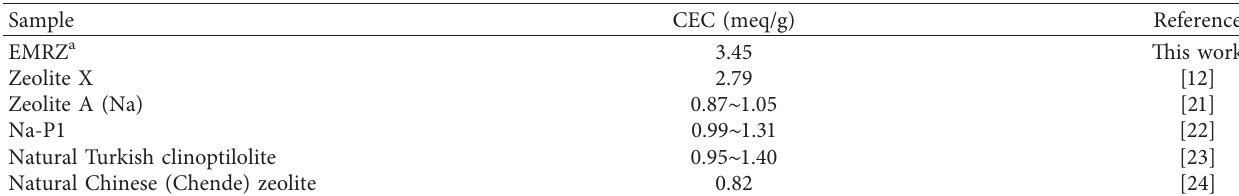
Table 3: Comparison of CEC value of the as-synthesized EMRZ and related typical